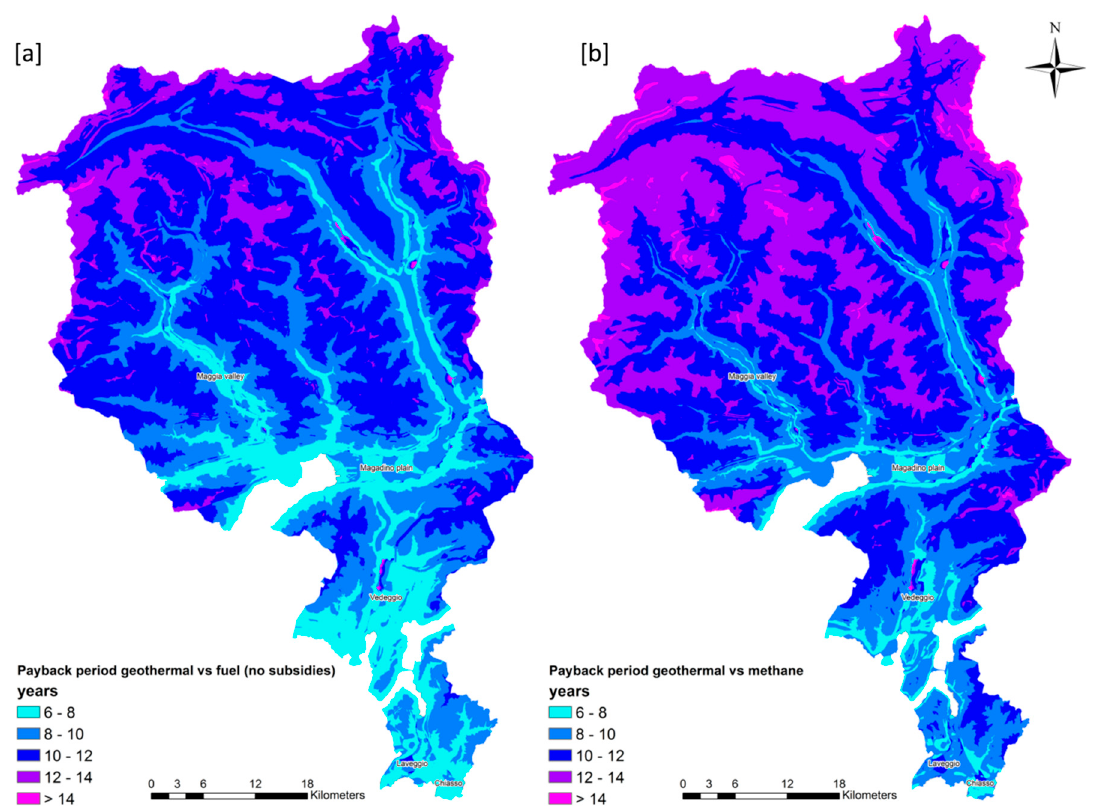
Figure 7. Maps of estimated payback period resulting from a geothermal vs heating oil analysis without considering economic subsidies ( a ) and geothermal vs natural gas ( b ).